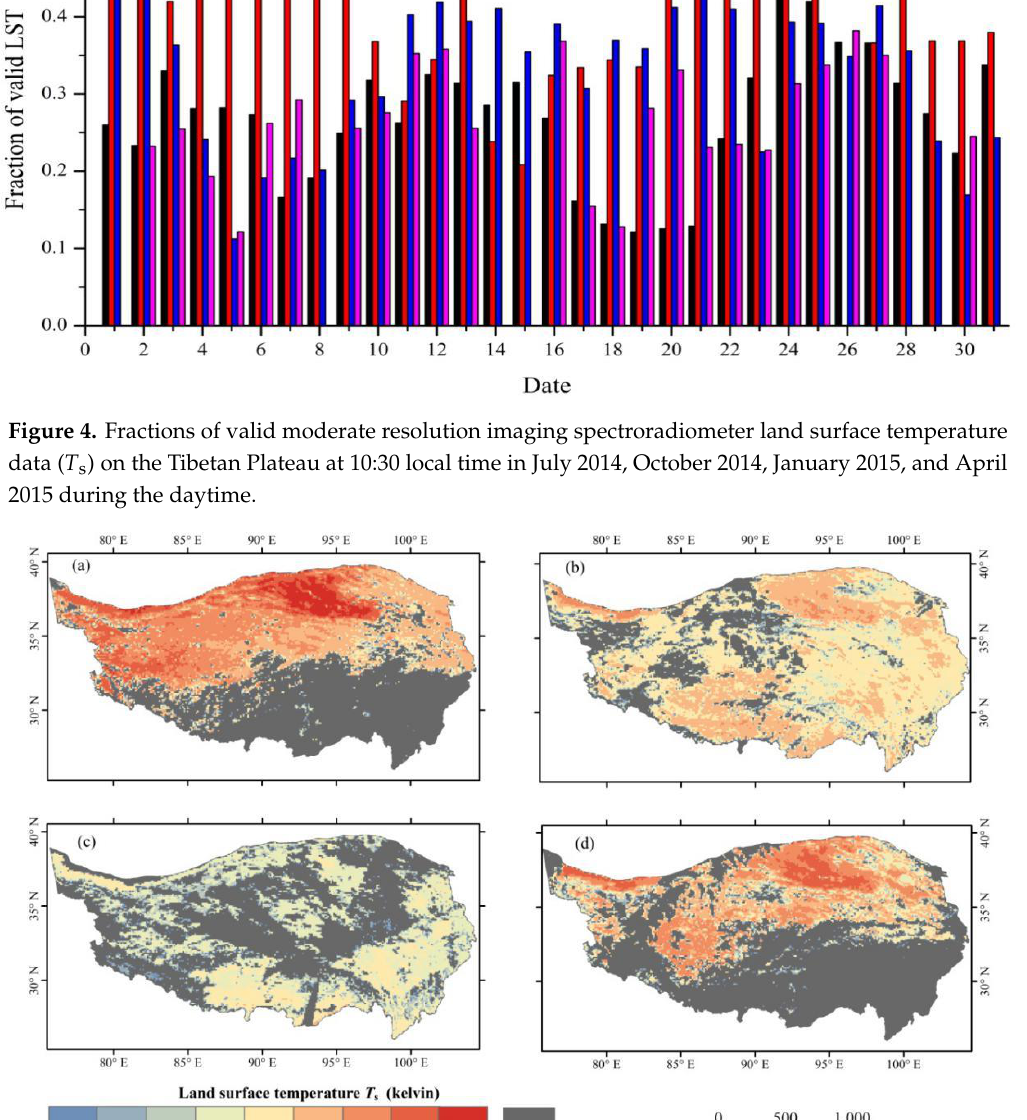
Figure 6. Spatial distribution of net radiation R n at 10:30 local time on July 24 ( a ) and October 25 ( b ) in 2014, and January 21 ( c ) and April 26 ( d ) in 2015. Note: R n stands for net radiation. The unit is W/m −2 .